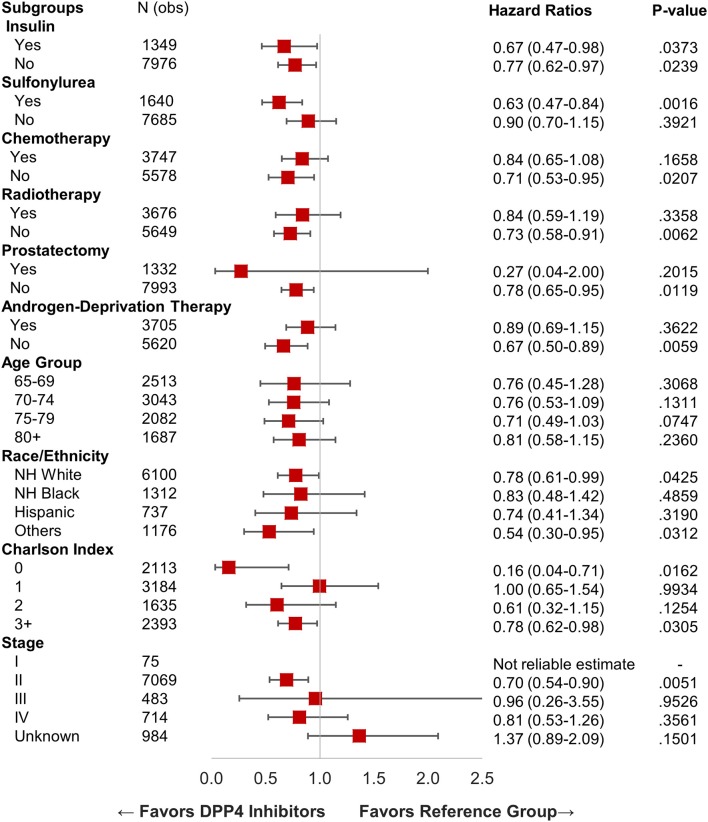
Forest plot with hazard ratio showing survival analysis of various subgroups within prostate cancer patients.